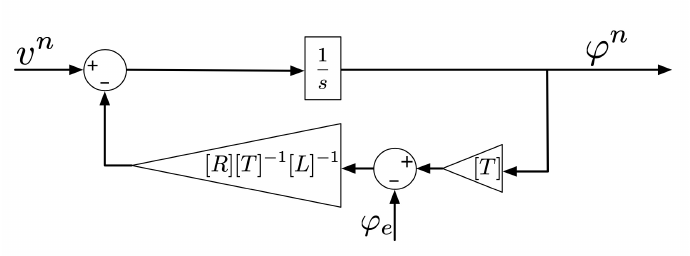
Figure 2. Implementation scheme for the function calculating the machine flux